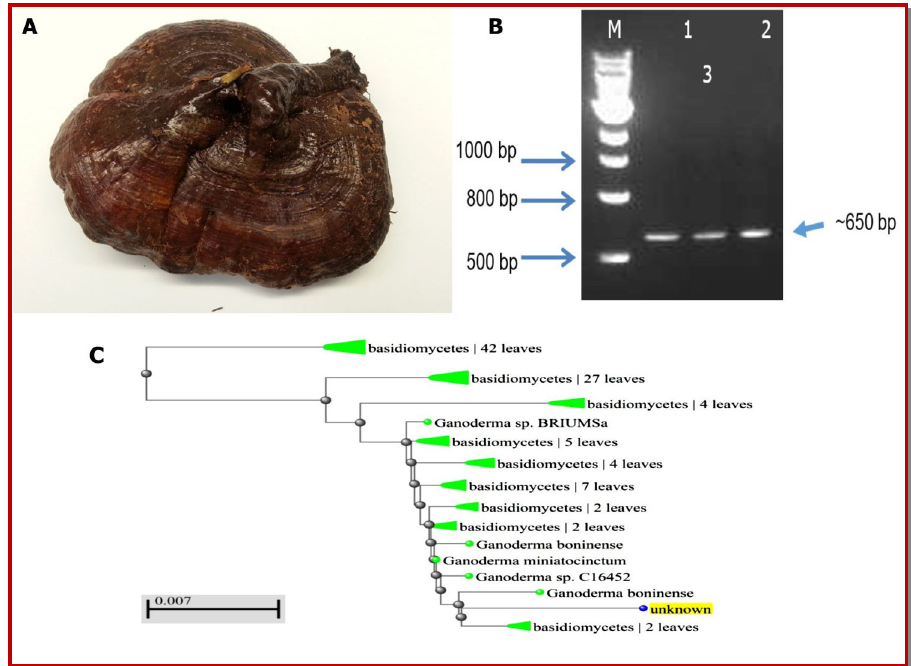
Figure 1: A) The fungal fruiting body obtained from oil palm tree; B) Polymerase Chain Reaction (PCR) analysis of the fungal fruit- ing body's DNA based on method described by Chong et al. (2011) shows that the PCR product is around 650 bp; C) Phylogenetic Tree analysis (using Basic Local Alignment Search Tool, BLAST, NCBI) of the fungal PCR product DNA sequence (highlighted in yellow) shows that the fungi identified as G. boninense